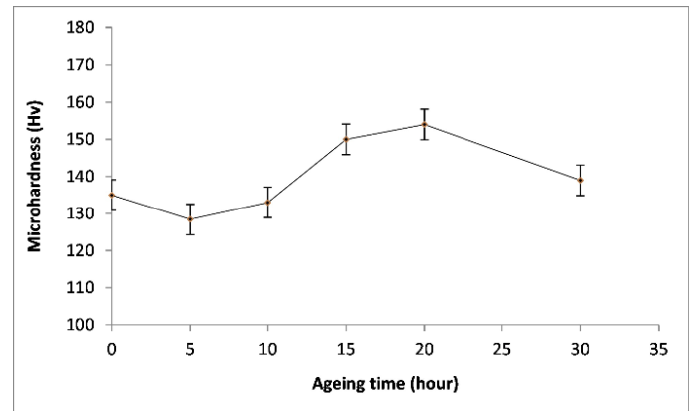
Fig. 5. Microhardness versus the aging time at 170 °C for 2017A-T4